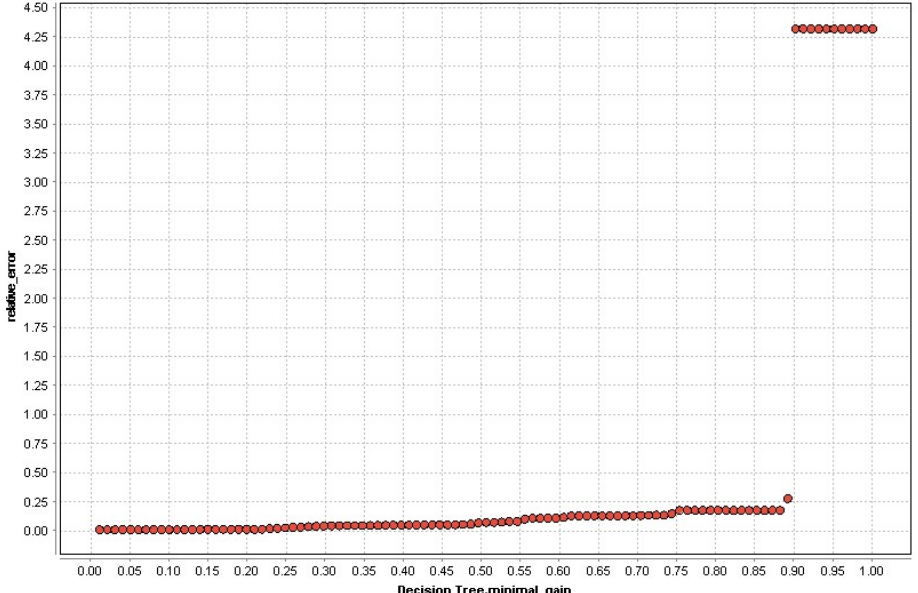
Figure 9. Minimal gain tuning results for Decision Tree model.